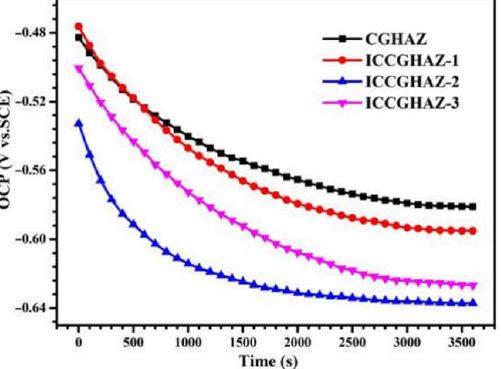
Figure 9. OCP dependent on the immersion time of the CGHAZ and ICCGHAZs with different secondary peak temperatures in 3.5 wt% NaCl solution.